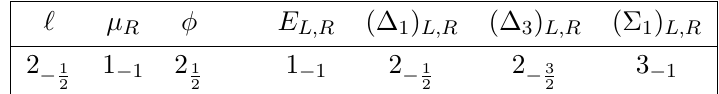
Table 1. List of particles in the model. The quantum numbers represent (SU(2) L )